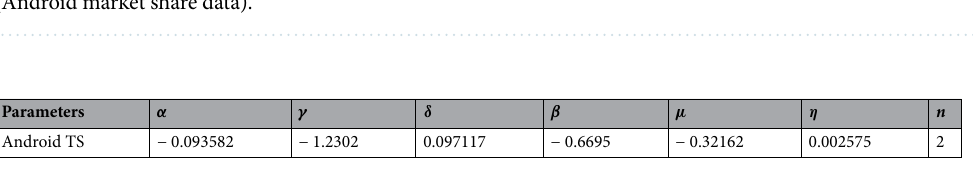
Table 3. Estimated Rulkov parameters for components x and y